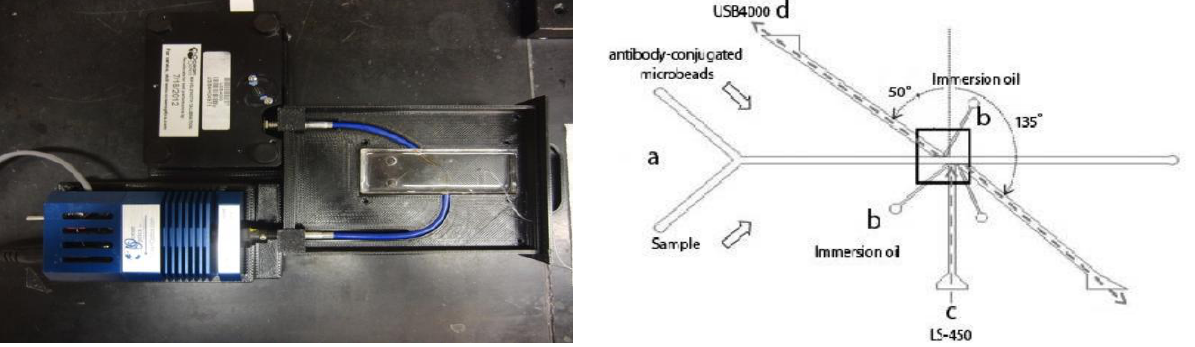
Figure 16. The lab-on-a-chip with optical waveguide channels to irradiate the main microfluidic channel and detect light scattering from it. Silicone oil within the optical waveguide channel acts as a core and the surrounding polydimethyl siloxane (PDMS) lab-on-a-chip acts as a cladding of an optical fiber. Reprinted from [107] with permission ©